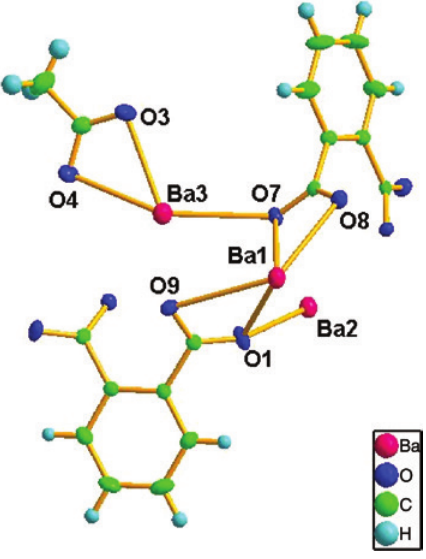
Figure 2: Asymmetric unit of the compound with atom numbering scheme.